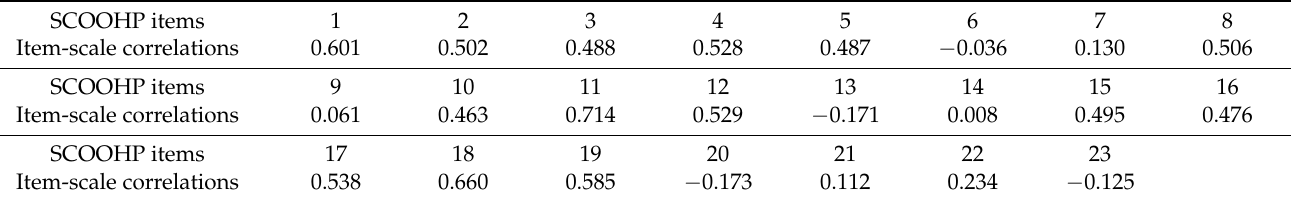
Table 1. Item correlation with a Global Score of SCOOHP 23 Items.